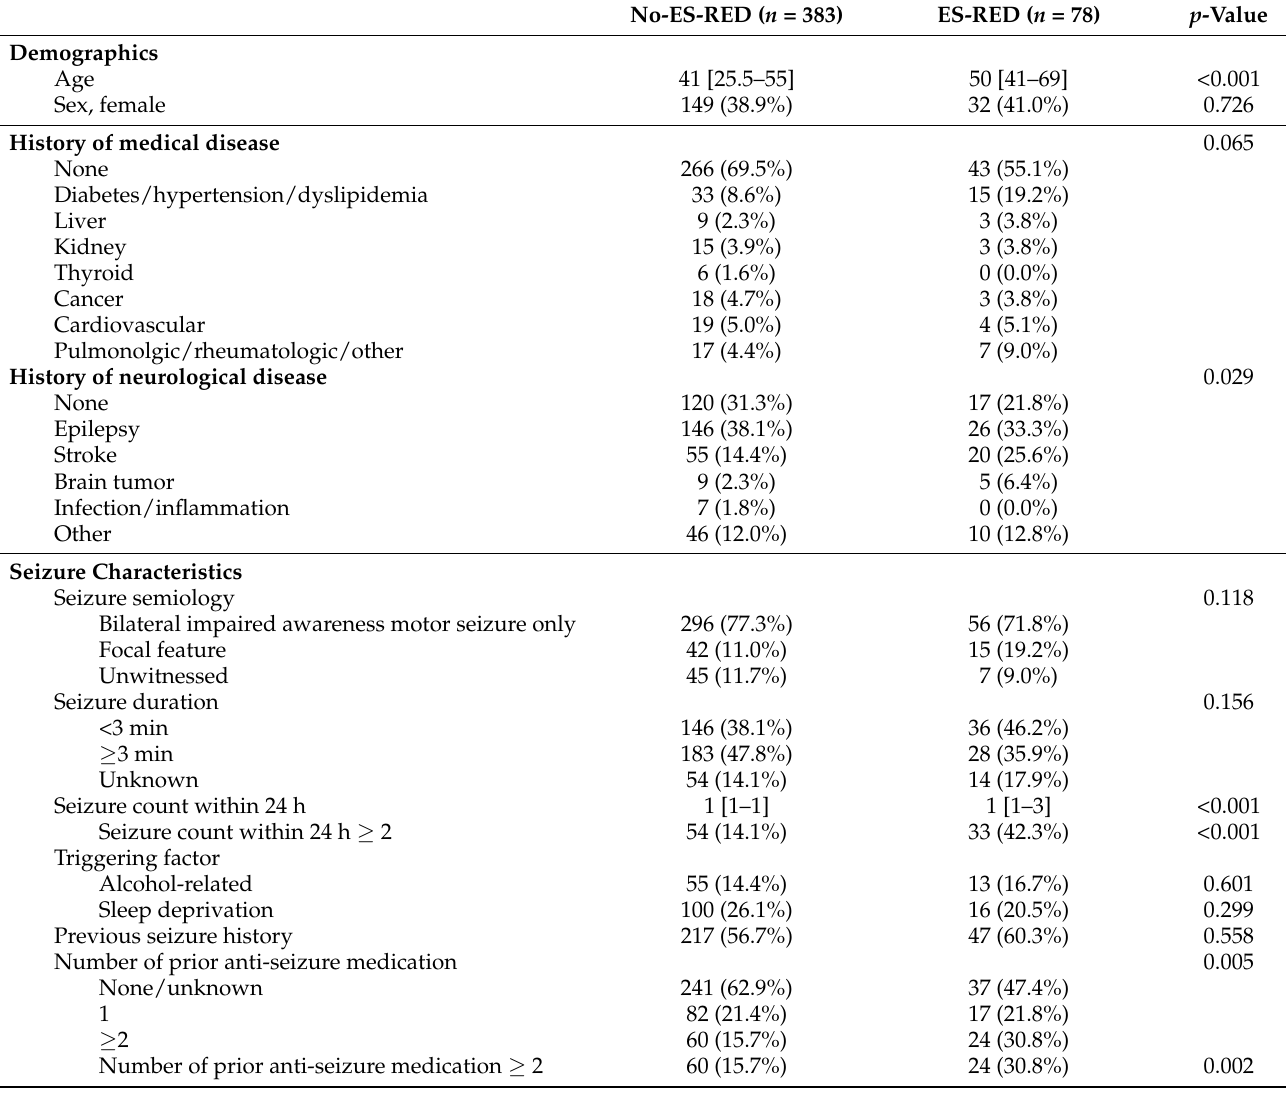
Table 1. General demographics of the derivation